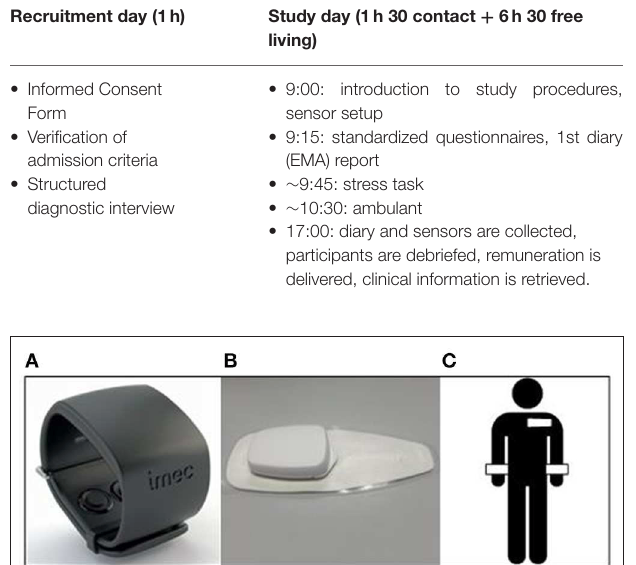
TABLE 2 | Study overview: recruitment day and study day. Recruitment day (1h)